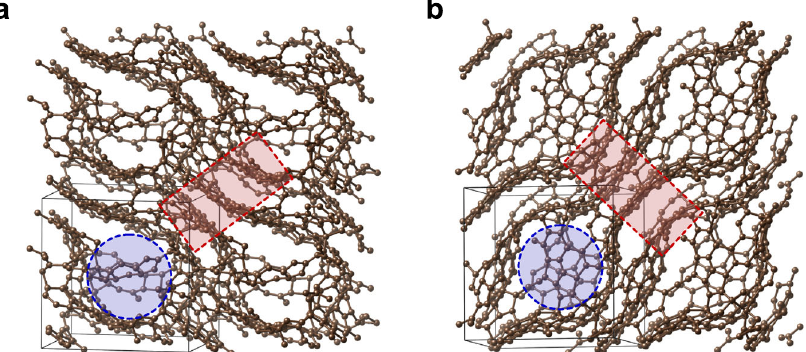
Fig. 6 The structure of MgO-templated HC. The structures of MgO-templated HC from the different initial structures. To show the graphite region, we present 2 × 2 × 1 supercell. The solid black line indicates the unit cell. Red box and blue circle show the graphite-like region and pore region,